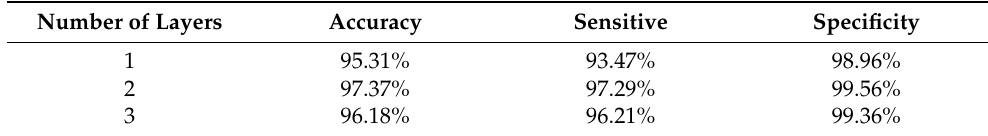
Table 6. Accuracy of the model at different LSTM